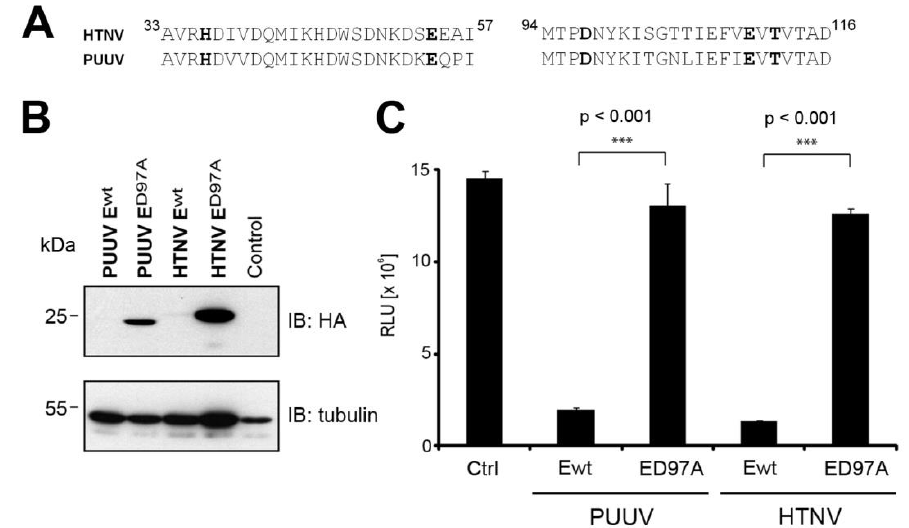
Figure 3. Puumala virus (PUUV) L protein possesses a functional endonuclease domain. ( A ) Sequence alignment of the N-terminal domains of HTNV and PUUV L protein. ( B ) BSR T7/5 cells were transfected with wt or D97A PUUV and HTNV L protein N-terminal constructs along with an NLuc reporter control plasmid. Cells were lyzed 48 hours post-transfection. Proteins were separated by SDS-PAGE and transferred on membranes for immunoblotting. ( C ) NLuc activity was measured using the Nano Glow ® Luciferase Assay System (Promega). Data are expressed as mean ± SD ( n = 3) and were analyzed by one-way ANOVA with p-values indicated.